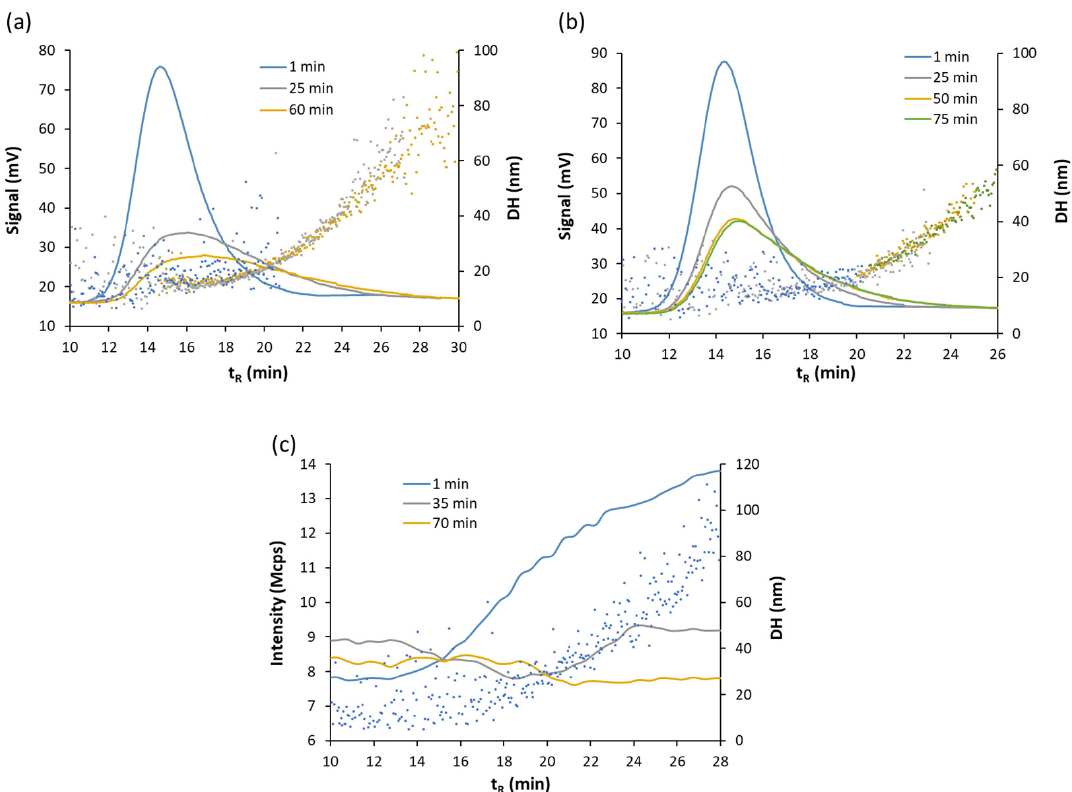
Figure 6. Fractograms (solid line) and hydrodynamic diameter (points) obtained for suspension of batches O2 ( a ) and O1 ( b ) diluted 1/4 with BW2 water at different times using UV-Vis detector. ( c ) Fractograms and hydrodynamic diameter for suspension of batch O2 diluted 1/4 with BW1 water at different times using the DLS signal.